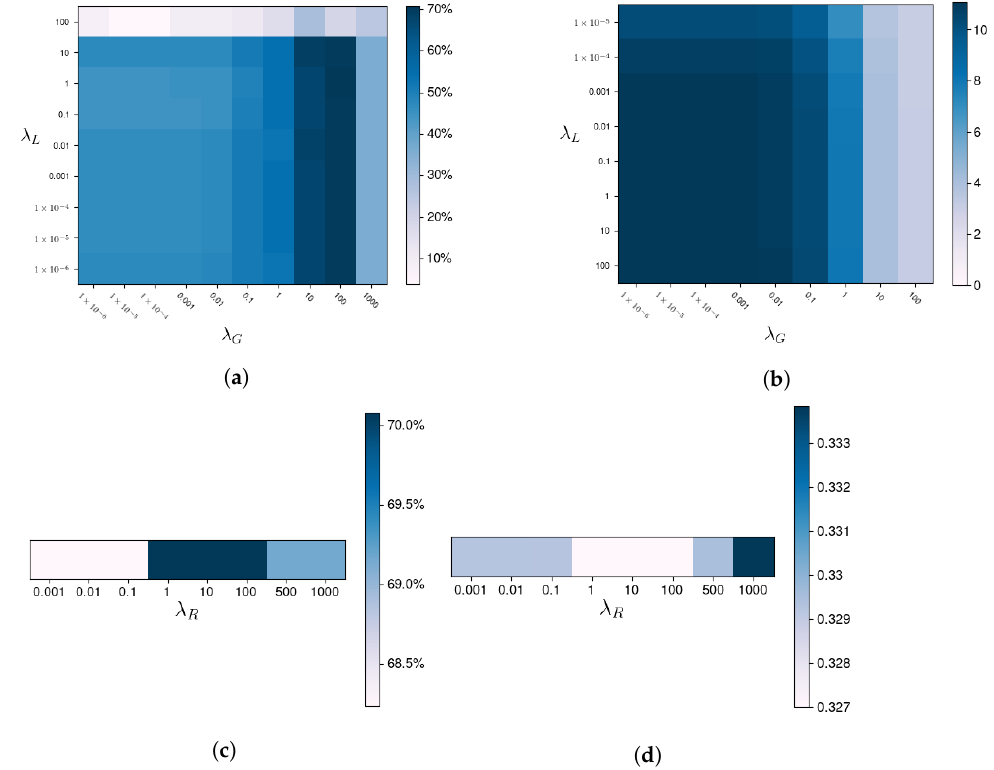
Figure 3. The average model performance over the cross-validation folds for different values of λ G , λ L , and λ R in terms of accuracy and MSE. ( a ) Accuracy as a function of λ L and λ G with λ R = 1. ( b ) MSE as a function of λ L and λ G with λ R = 1. ( c ) Accuracy as a function of λ R with λ G = 100 and